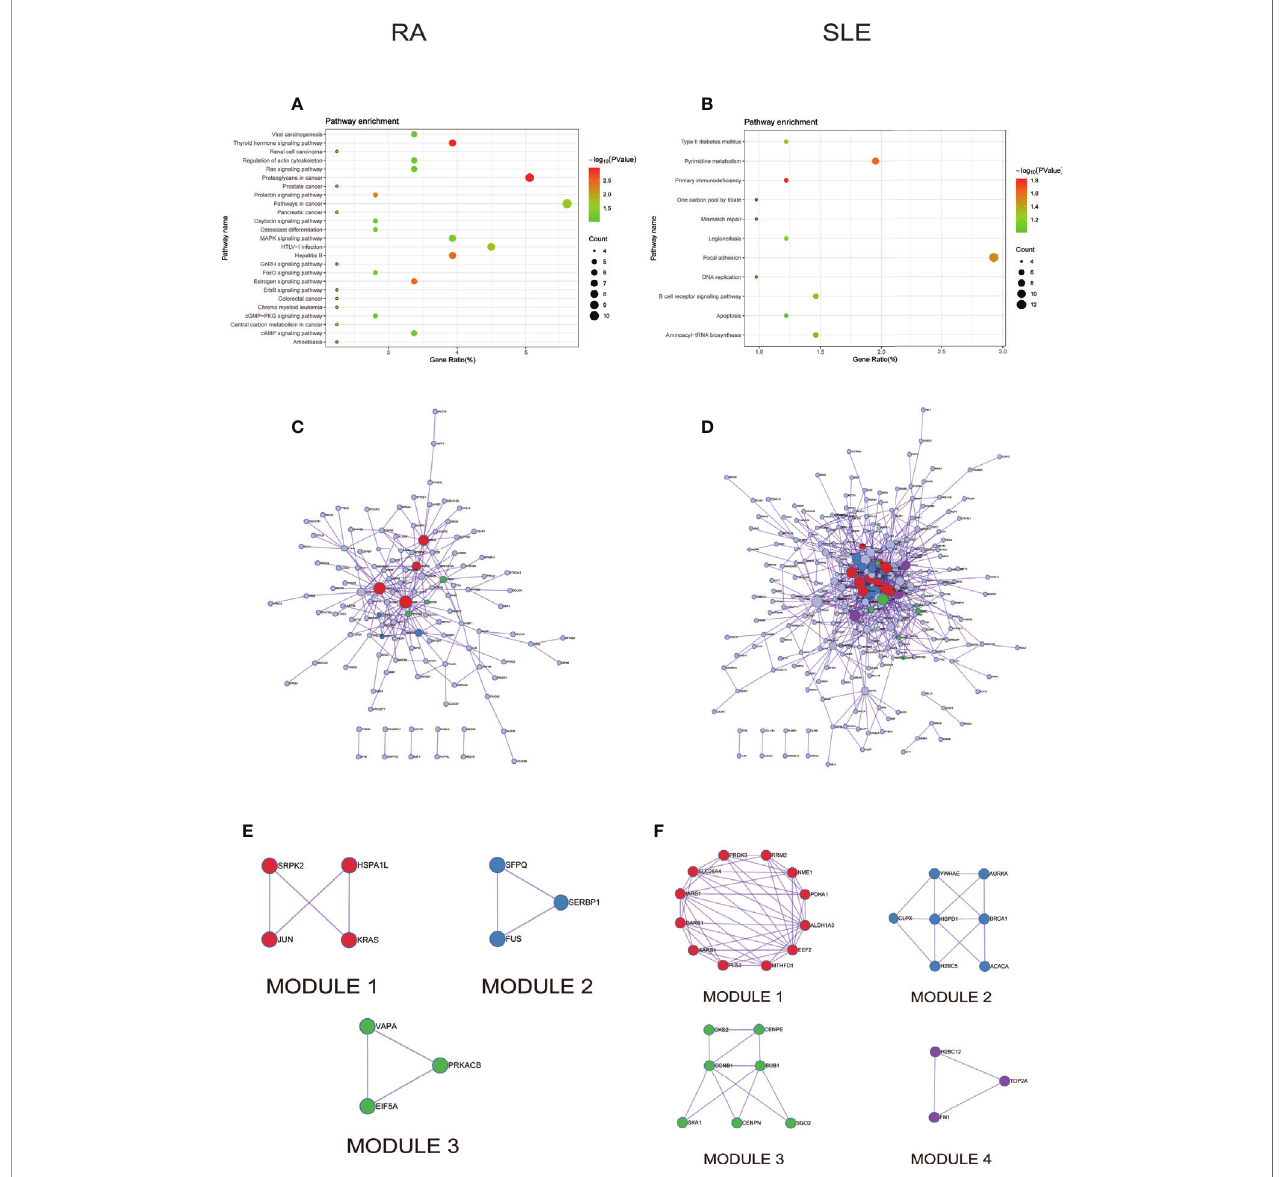
FIGURE 7 | The KEGG pathway analysis, PPI network and the most signi fi cant modules between RA and SLE in CD4 + T cells. (A, B) KEGG pathway analysis of RA and SLE; (C, D) PPI network of CD4 + T cells analyzed by String software between RA and SLE; (E, F) The signi fi cant modules of CD4 + T cells identi fi ed by MCODE between RA and SLE. DEG: differentially expressed gene; PPI: protein-protein